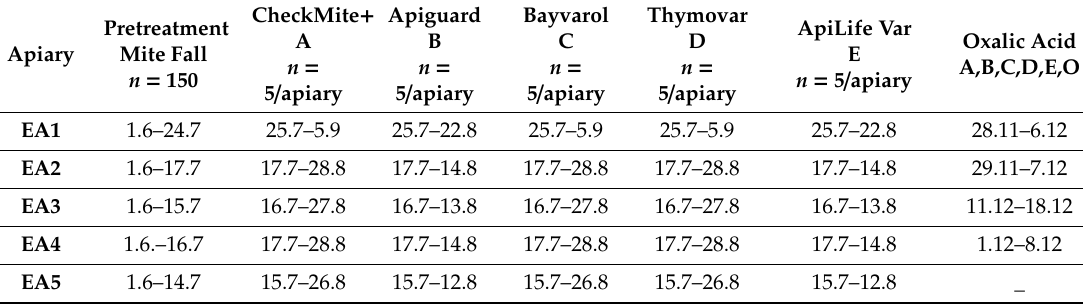
Table 1. Field trail